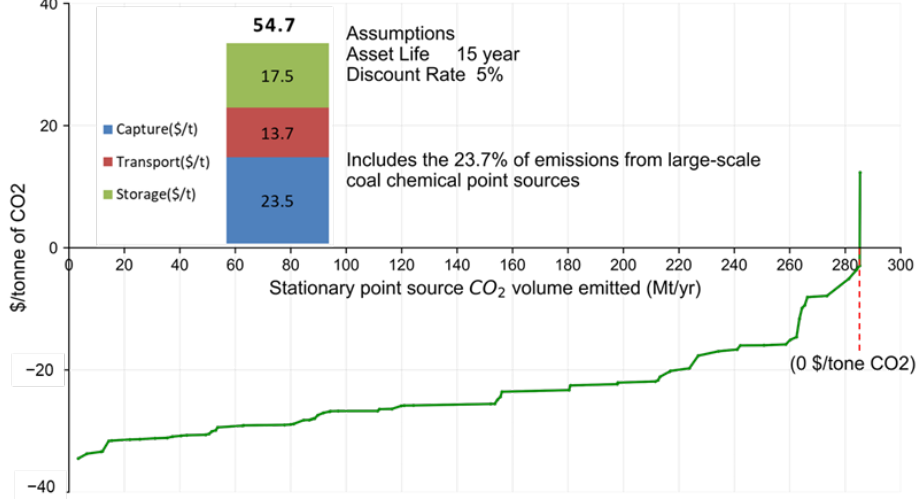
Figure 6. CCS cost curve of CO 2 -EOR whole process project in modern coal chemical industry.